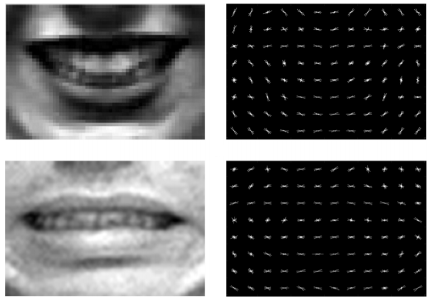
Figure 20. HOG descriptors of the mouth of two subjects from the CK+ database